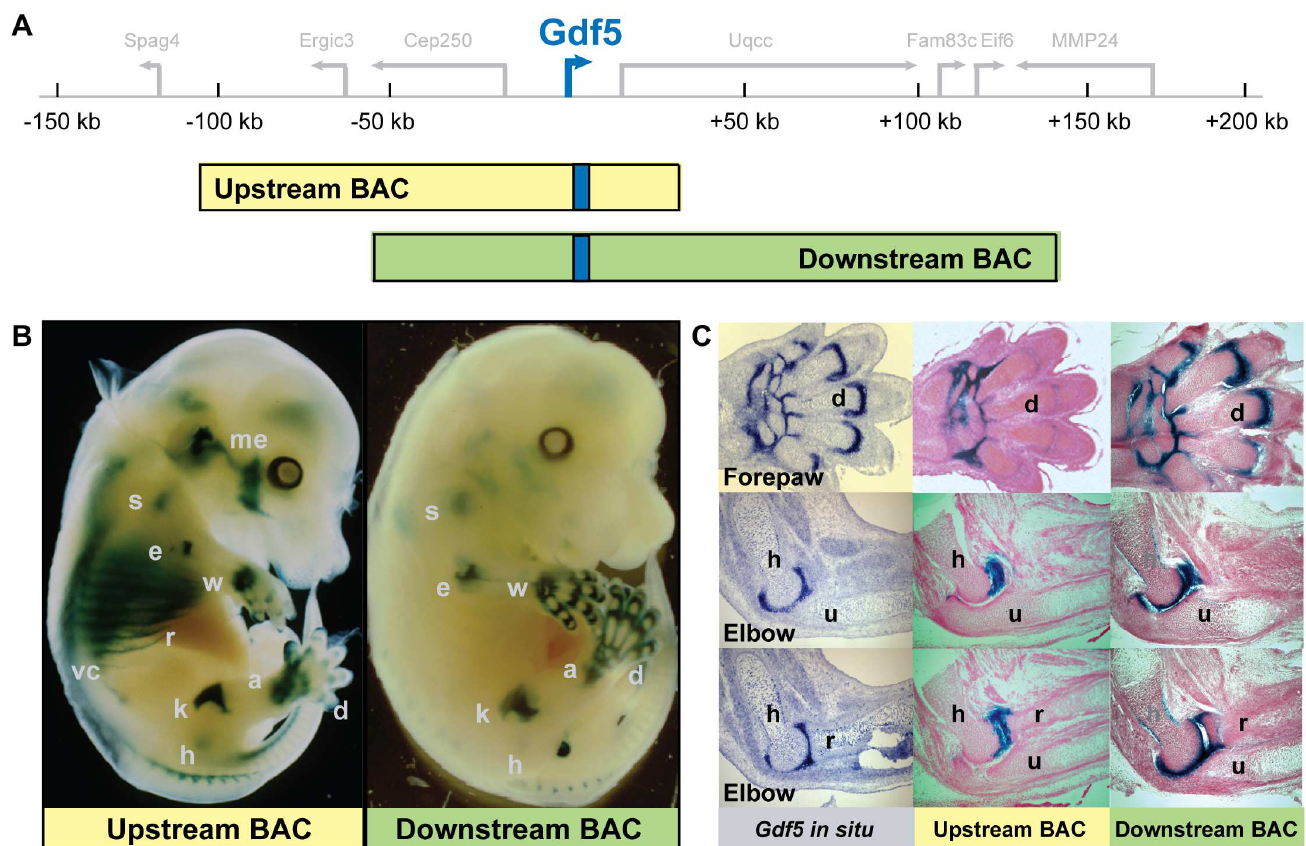
Fig 1. BAC scan of Gdf5 region revealsboth upstream and downstream regulatory domains for joint expression. ( A ) Relativelocation of two BACs spanning the Gdf5 region. Upstream BAC (yellow) extends 110 kb upstream to 30 kb downstream of Gdf5 codingexons, while the Downstream BAC (green) spans an additional 109 kb downstream. IRES- β Geo cassette insertion (blue bar) within the 3’UTR of the Gdf5 coding exons of each BAC generates a visual reporter of Gdf5 expression. ( B ) Representative transgenicembryosat E14.5 derived from each BAC. Both BACs drive lacZ expressionin synovial joints of the proximallimb, such as the shoulder(s), elbow(e), hip (h, expressionis deep in the tissue), and knee (k); as well as the distal limb, such as the wrist (w), ankle (a), and digit joints (d). Additionally,expressionwas detected in axial tissues such as the ribs (r), in and aroundvertebral column (vc), and some sites in the head, such as the middle ear (me). In general,the Upstream BAC drove stronger proximallimb expressionwhilethe Downstream BAC drove stronger distal limb expression. ( C ) E14.5 embryonicforepaw and elbow sections comparing the endogenous Gdf5 expressionpattern via in situ hybridization (left) with the lacZ patterns driven by the Upstream (middle)and the Downstream BACs (right). Note that the endogenous Gdf5 gene is expressedin stripes at most sites of joint formation, including both the humeroulnar (h-u) joint and the humeroradial (h-r) joints of the elbow. The Upstream BAC drives expressionin many proximallimb joints, but only in the humeroradial and not the humeroulnar joint of the elbow. In contrast, the Downstream BAC drives comprehensive appendicular joint expression, includingboth joints of the elbow. All expressionpatterns were confirmedin multiple independent transgenicembryos (S1